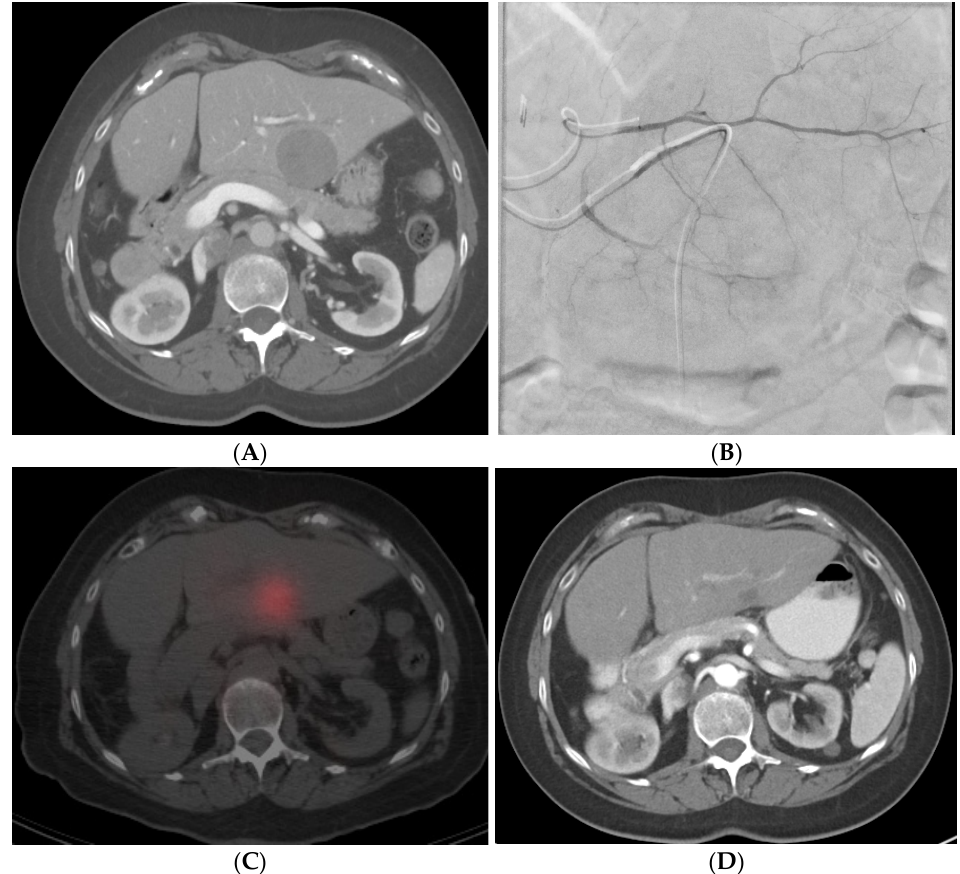
Figure 5. Radiation segmentectomy in a patient with HCC with a past surgical history of right hepatectomy. ( A ) CT showing a large lesion in the left lobe of the liver. ( B ) Left hepatic artery angiogram showing vessels supplying the tumor. ( C ) SPECT-CT imaging after left segment-2 sub-segmentectomy, showing good dose delivery. ( D ) Follow-up CT showing good response in the treated area.